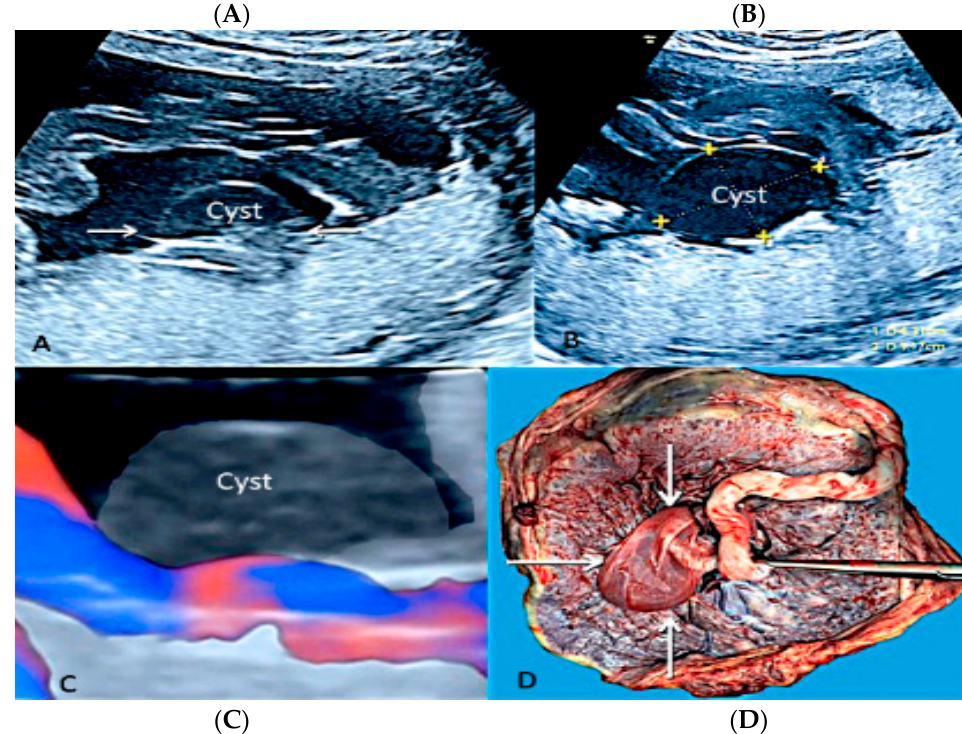
Figure 14. Two-dimensional ( A,B ) and three-dimensional ultrasound with HD flow using “glass body” mode ( C ) showing chorionic plate cyst. It depicts an anechoic thin-walled structure on the fetal surface of the placenta near the cord insertion (arrows) ( A , B ) without internal vascularity ( C ). Pathologic correlation (arrows) ( D ).